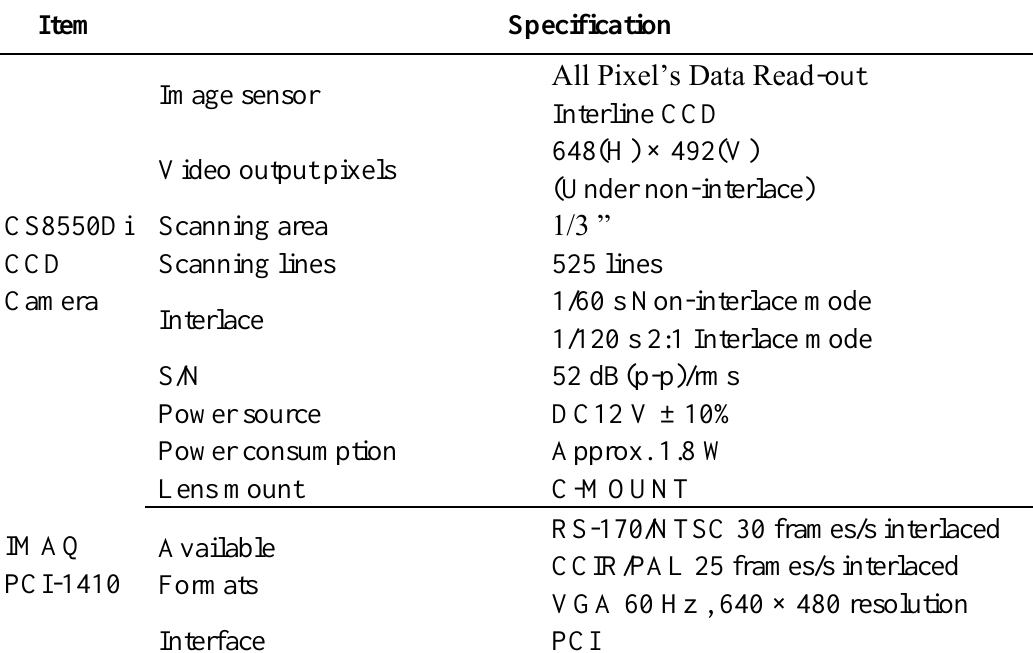
Table 1. The specifications of the CCD Camera and image acquisition